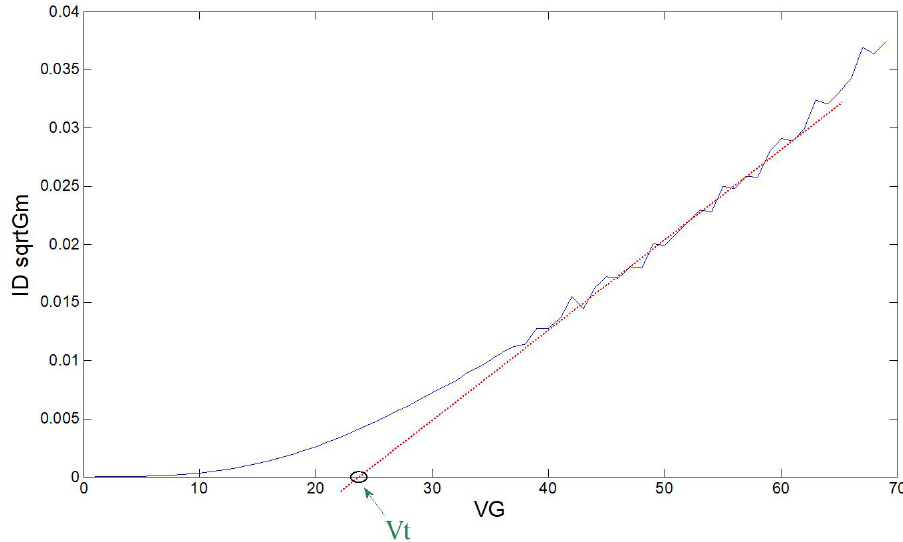
Figure 13. Threshold voltage